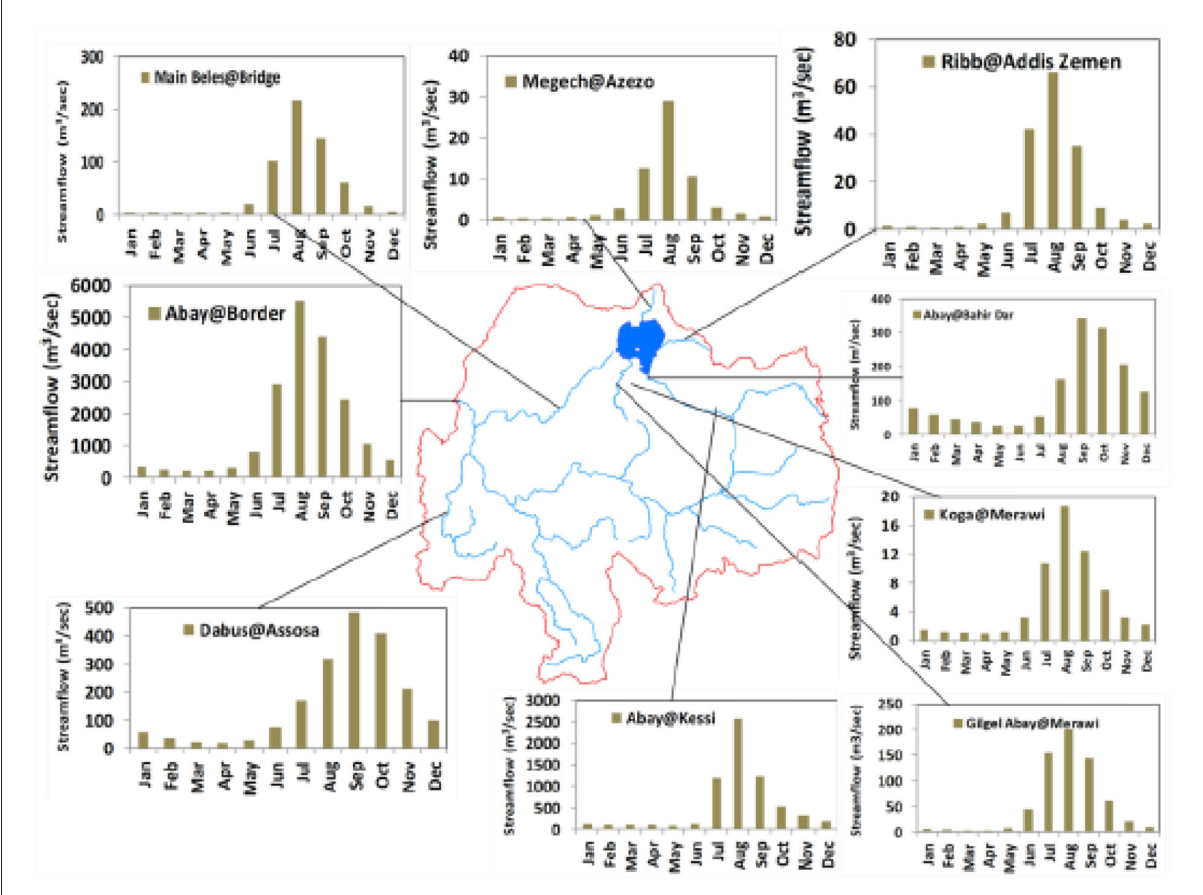
FIGURE6 Stream flows measured in Abbay basin. Source (Ayele et al.,